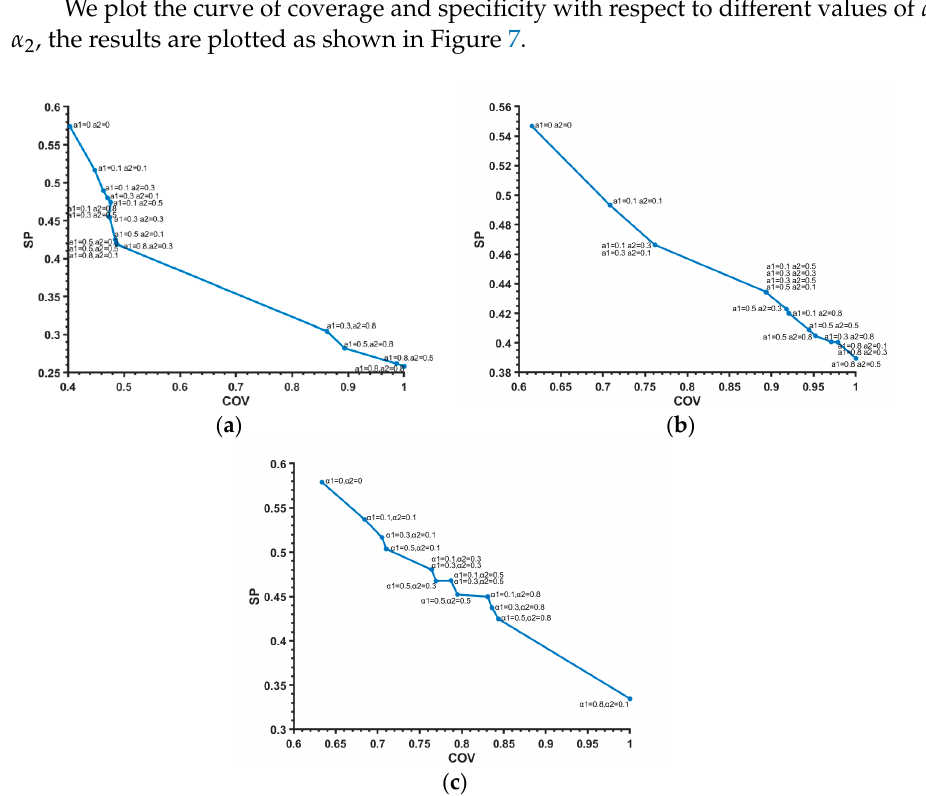
Figure 7. The curves of COV - SP with di ff erent values of α 1 and α 2 ( a ) Cluster 0 ( b ) Cluster 1 ( c ) Cluster 2.